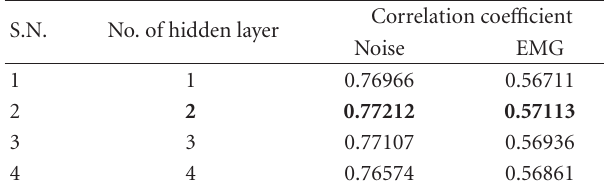
Table 3: Number of hidden layer and r